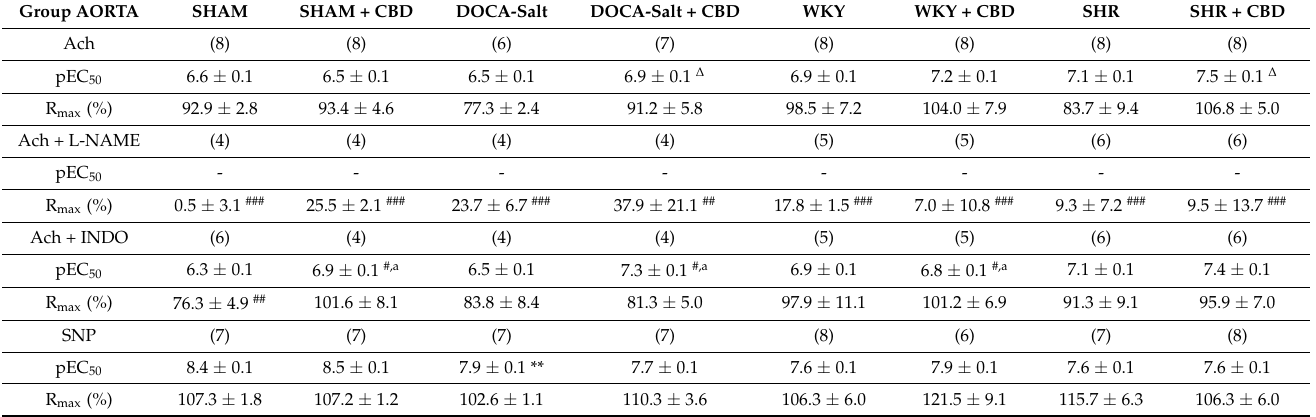
Values are based on the concentration-response curves shown in Figures 1–3. CBD 10 mg/kg or its vehicle were injected i.p. every 24 h for 14 days. Aortas were isolated 24 h after the final dose of CBD or its vehicle. The numbers of animals are shown within